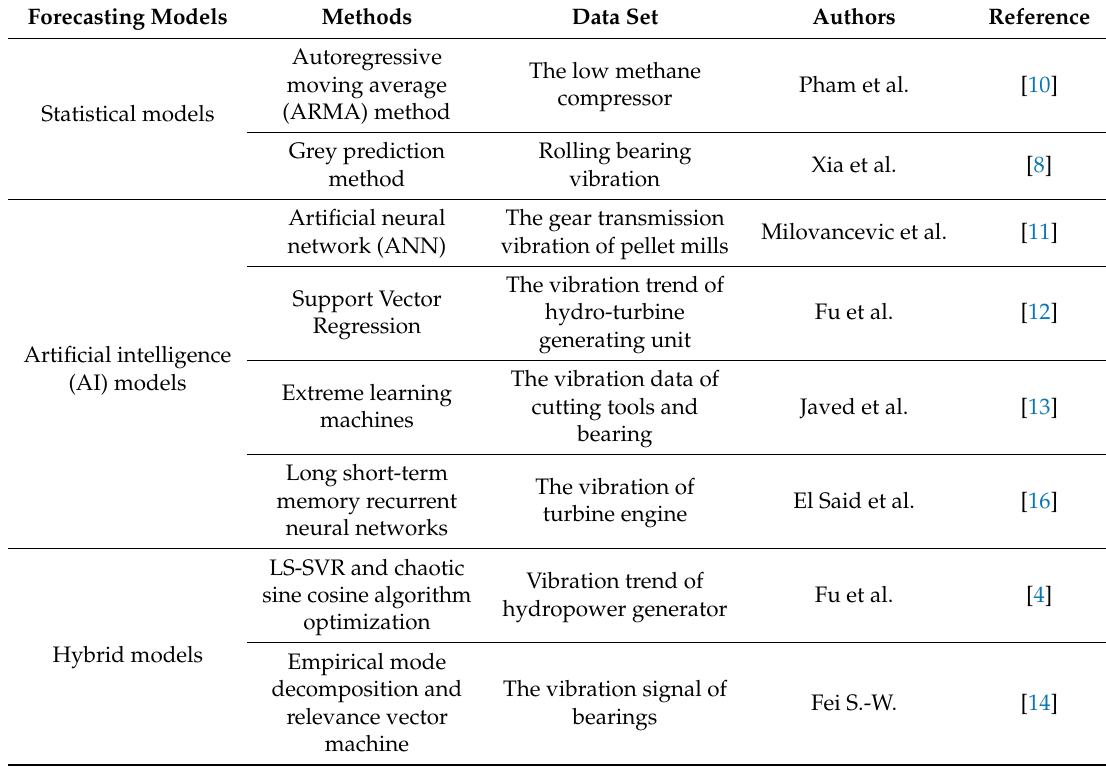
Table 1. Summary of literature on vibration tendency